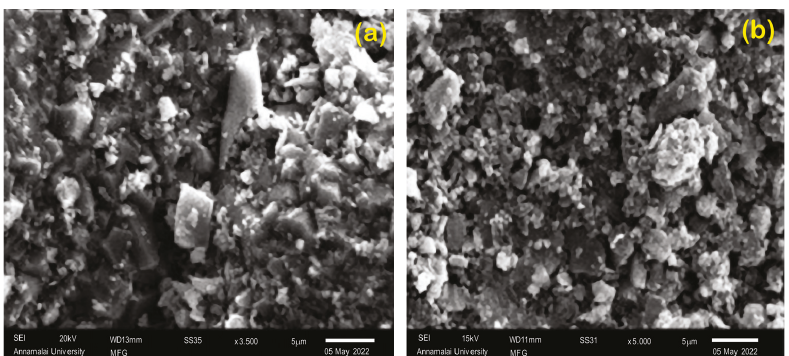
Figure 6: (a, b) SEM images of silicon carbide and boron carbide